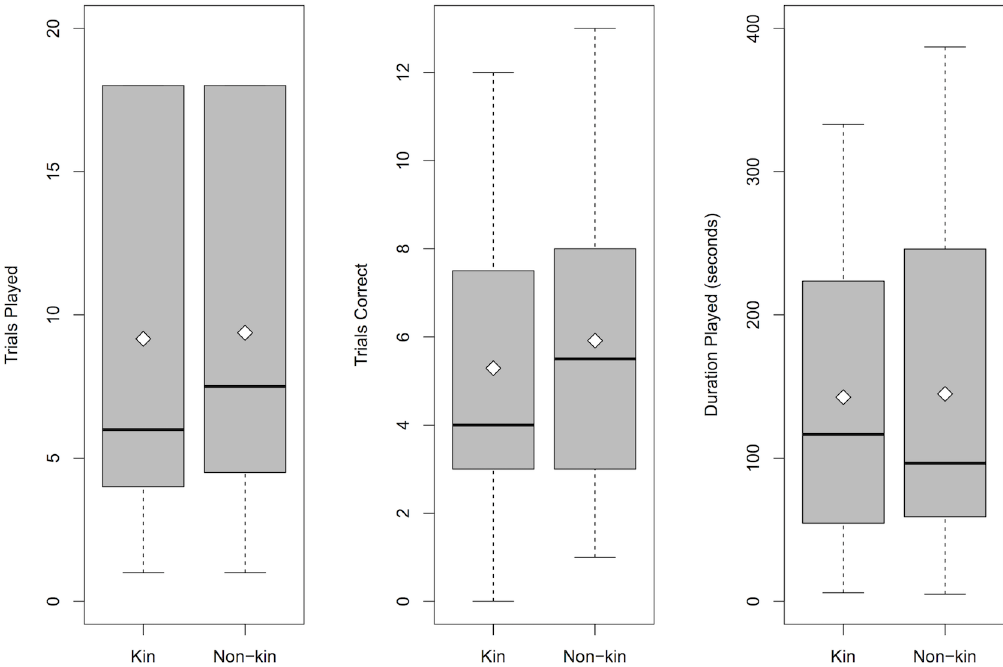
Fig 3. Children’s performance in the visual form analysis task at 5.5 years. Children’s ( n = 24) performance in the visual form analysis task, as measured by (A) number of trials played for kin and non-kin, (B) number of trials answered correctly for kin versus non-kin, and (C) duration of play for kin versus